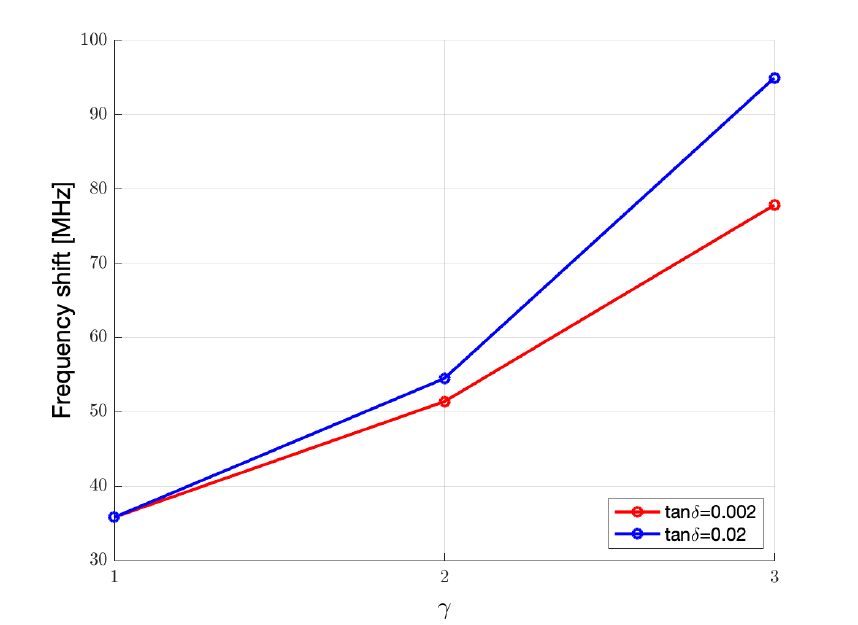
Figure 9. Simulated sensor cell on FR4 substrate with artificial ( tan δ = 0.002) and real ( tan δ = 0.02) loss tangent values and exposed to different humidity